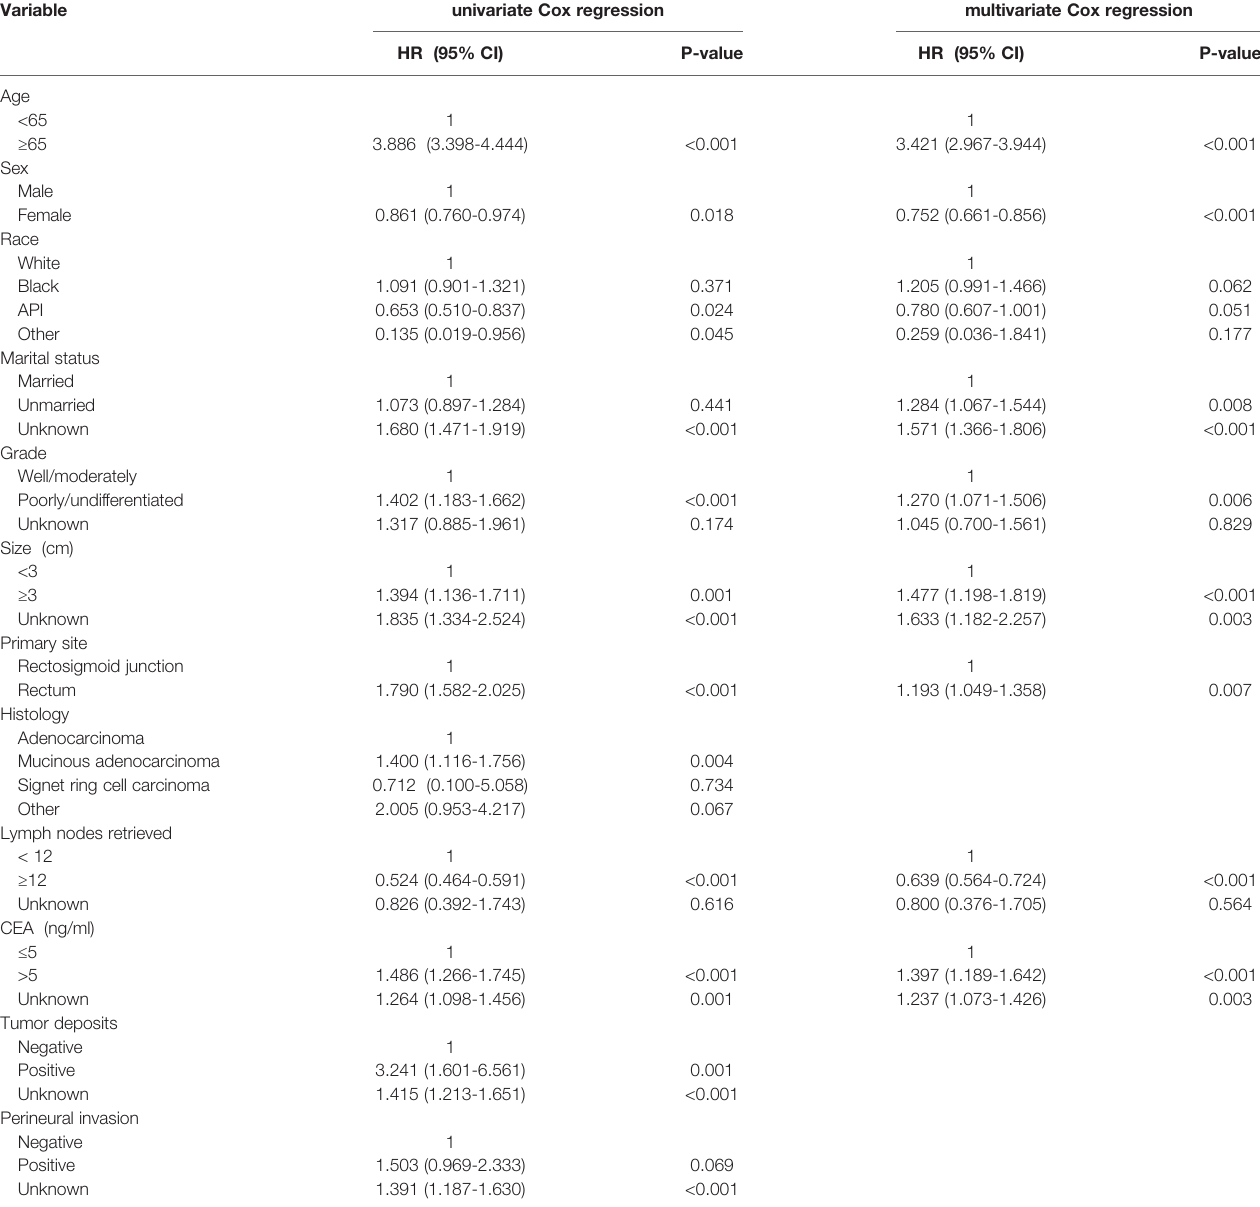
TABLE 2 | The univariate and multivariate analyses of factors associated with overall survival. Variable